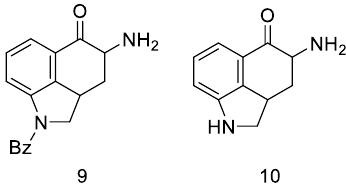
Figure 10. Structural formulas of amine derivatives ( 9 and 10 ).